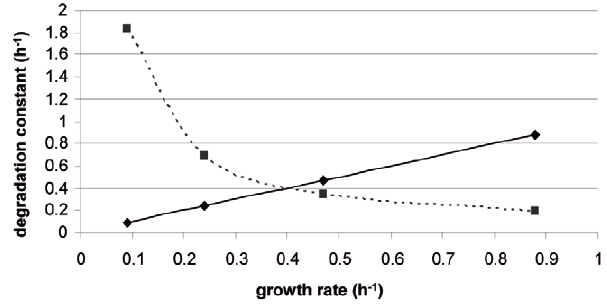
Figure 4. Competition between dilution and degradation rates for protein control. Comparison of growth rate ( m : straight line) and median value of the degradation constant (k 0 : dotted line).